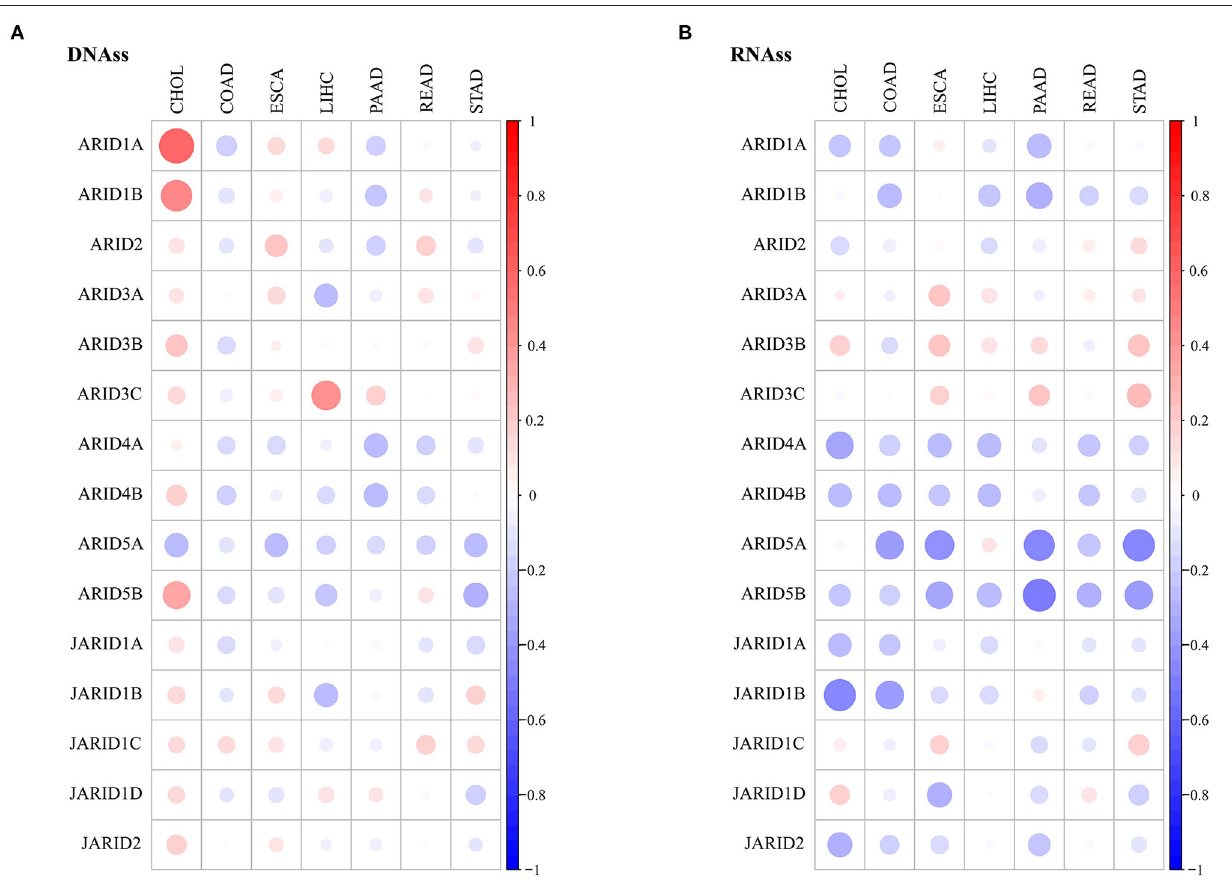
FIGURE 4 | Association of ARIDs expressions with tumour stemness. Correlations between ARIDs expressions and DNAss (A) or RNAss (B) of digestive cancer. Bigger dot stands for higher correlation